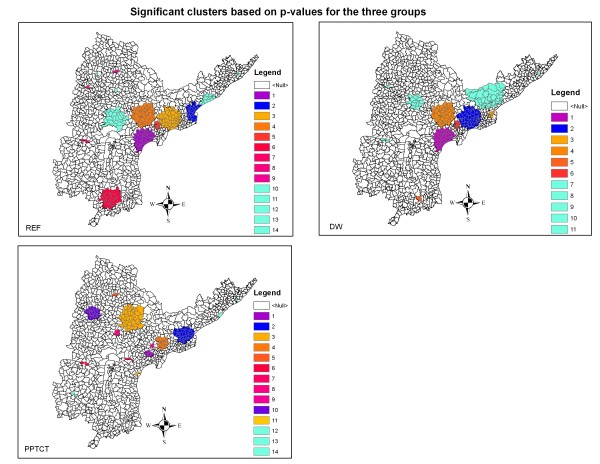
clusters. Results of cluster analysis showing the significant clusters for IREF, IDW and IP. Clusters shown in cyan are non-significant ones as based on the p-values.